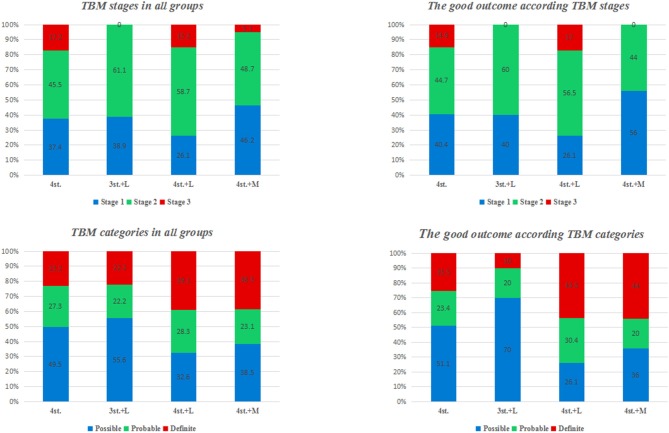
the percentage of TBM patients in each stage and category at admission; and the percentage of patients with good outcome in each stage and category.